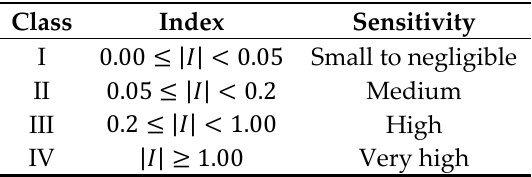
Table 2. Sensitivity index classes.